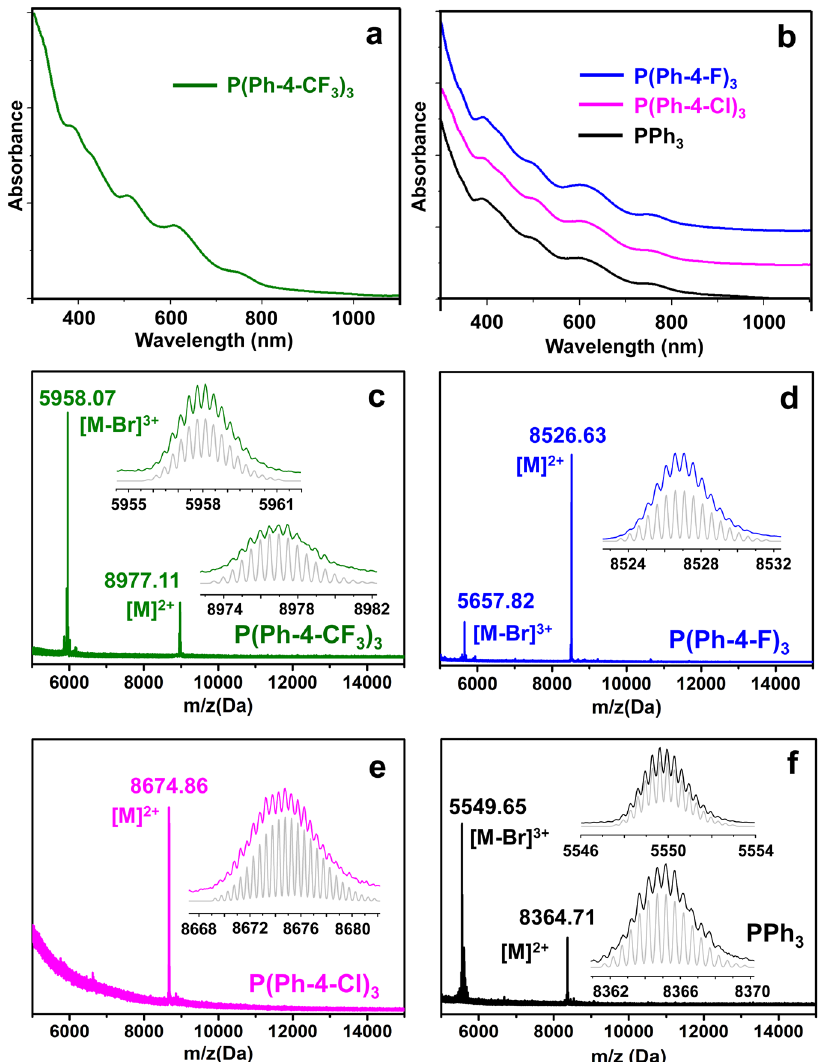
Fig. 1 Characterization of Au 56 NCs containing different phosphines. Experimental UV-vis optical spectra of a [Au 56 (SPh- t Bu) 24 (P(Ph-4-CF 3 ) 3 ) 6 Br 2 ] 2 + NC and b [Au 56 (SPh- t Bu) 24 (P(Ph-4-X) 3 ) 6 Br 2 ] 2 + (X = F, Cl, or H) NCs. c – f The ESI-MS spectra of the corresponding NCs. The gray pro fi les in all insets are the simulated isotope patterns which match well with the experimental data of